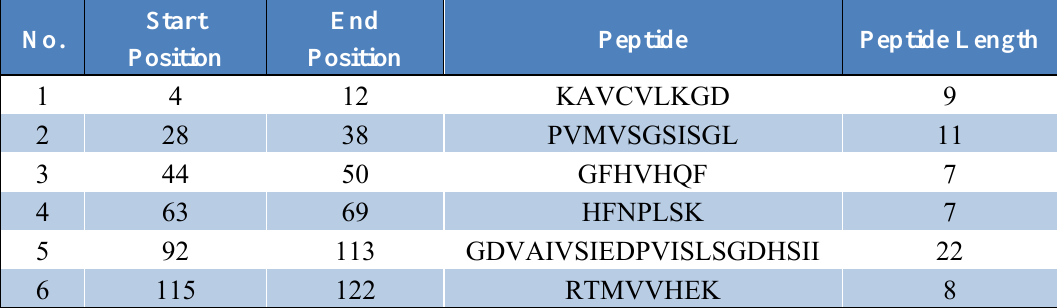
Table 4. The antigenic amino acid sequences and its position are listed.